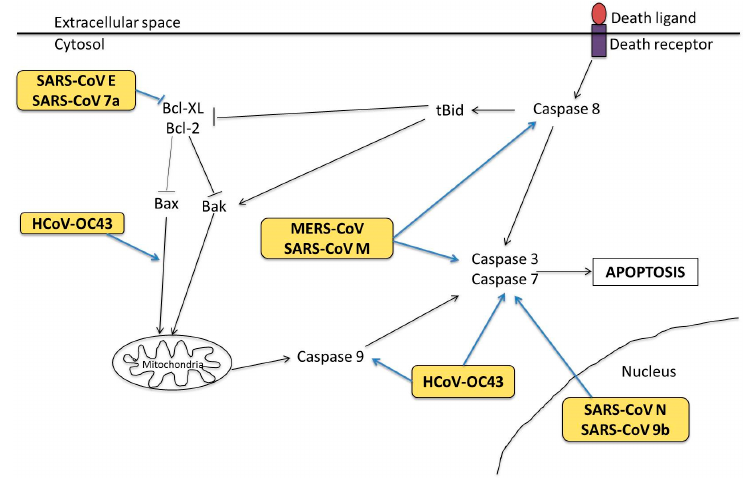
Figure 4. Activation of apoptosis by HCoVs. Binding of death ligands to death receptor induces caspase 8 activation, which in turn activates effector caspases 3 and 7 to stimulate apoptosis. On the